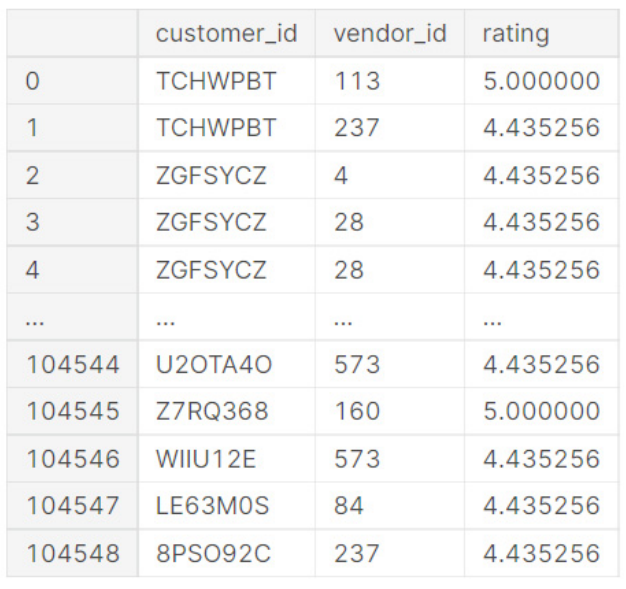
Figure 29. Distribution map of restaurant rating dataset.